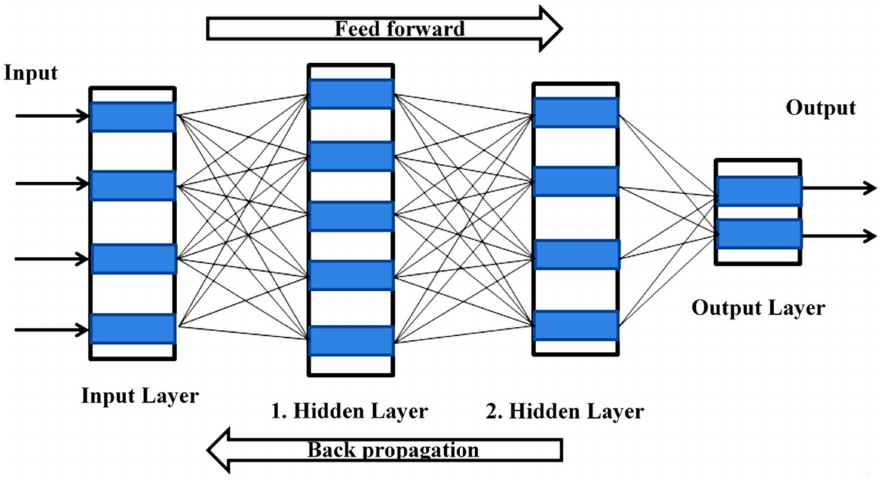
Figure 5. Execution process of ANN model